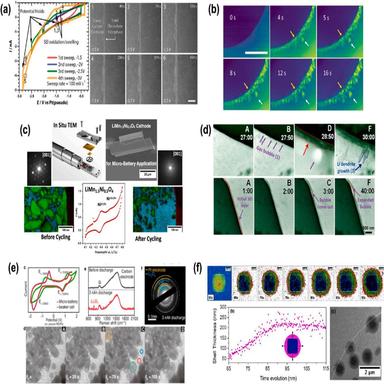
.2. Electrochemical Liquid TEM for monitoring electrochemical processes inside Li-on battery. (a) Voltammetry cyclic and TEM image in liquid electrolyte during the formation of solid electrolyte interphase on glassy carbon electrode; (b) TEM-sequential STEM image showing the growth of Li2O2 on glassy carbon electrode in a micro-battery of LiO2 system with liquid electrolyte saturated with oxygen; (c) In situ voltammetry cyclic and structural modifications of LMNO FIB lamella afte